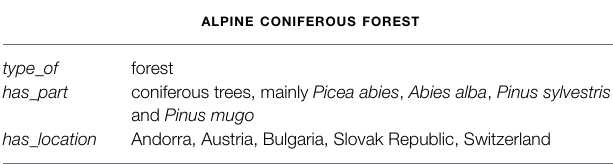
TABLE 9 | alpine coniferous forest